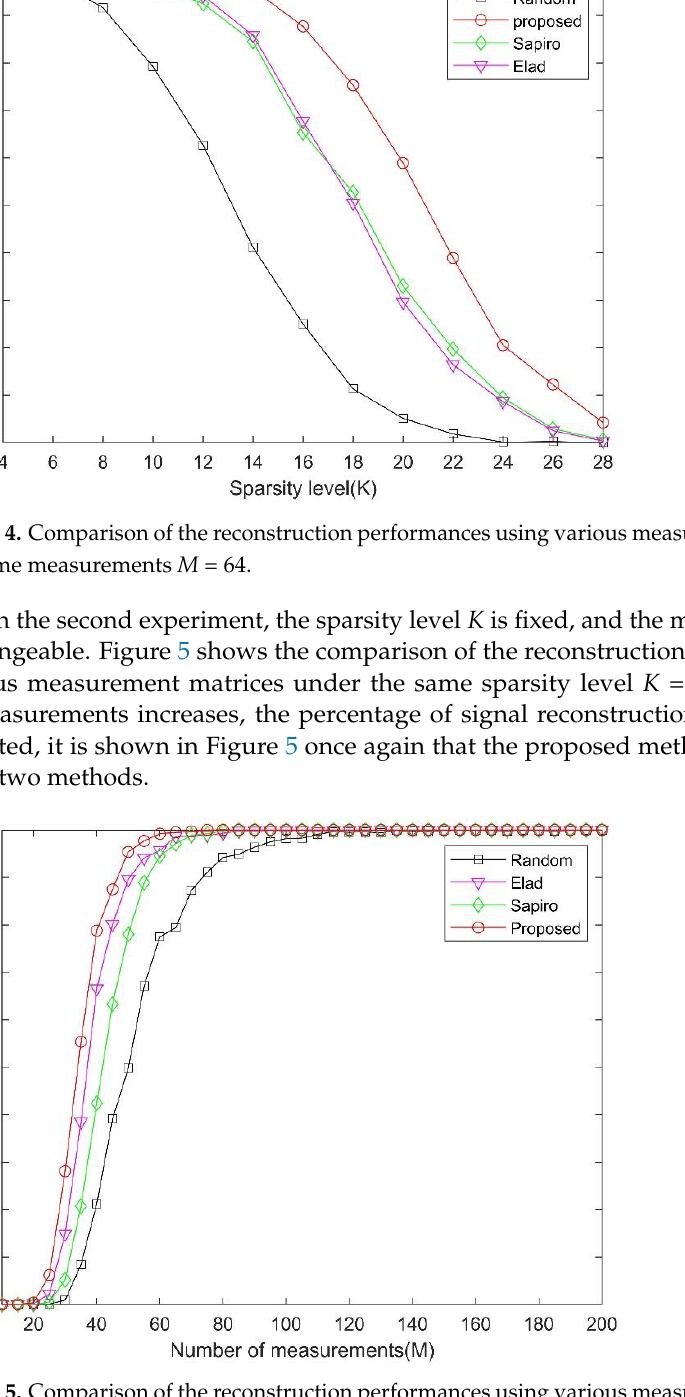
Figure 5. Comparison of the reconstruction performances using various measurement matrices under the same sparsity level K = 10. the same sparsity level K =